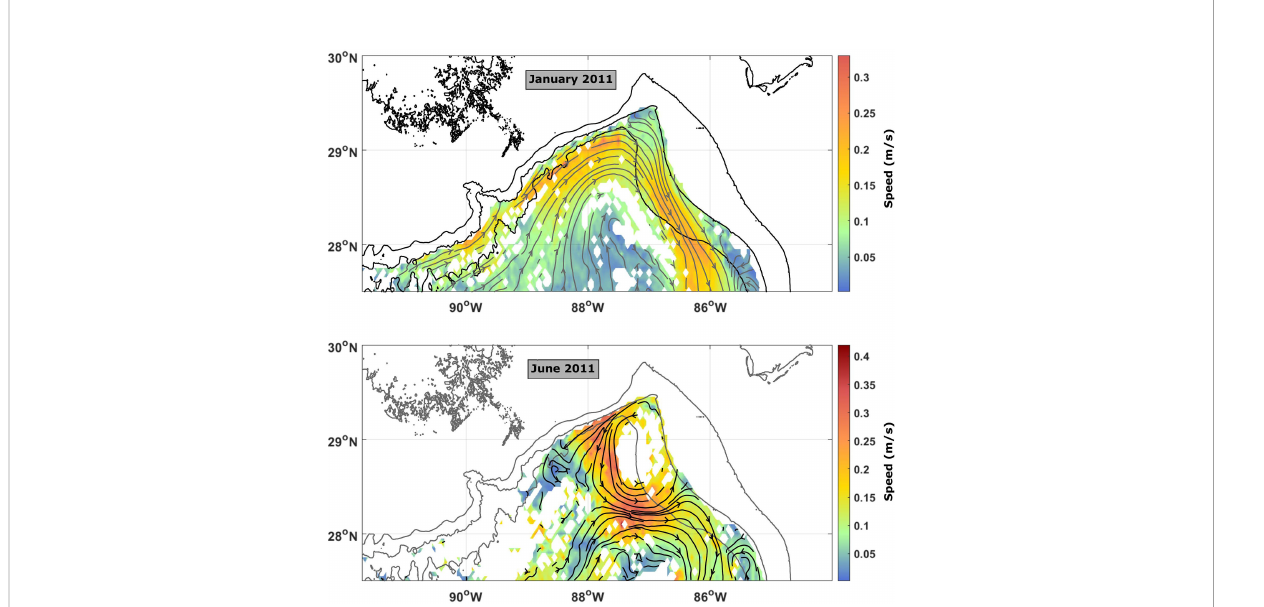
FIGURE 4 Pseudo-Eulerian velocity fi elds for (top) January 2011 and (bottom) June 2011, calculated from virtual particle velocities binned in a 0.05° × 0.05° geographical grid. Mean speed is colored, and streamlines are given in black. Isobaths are shown in dark